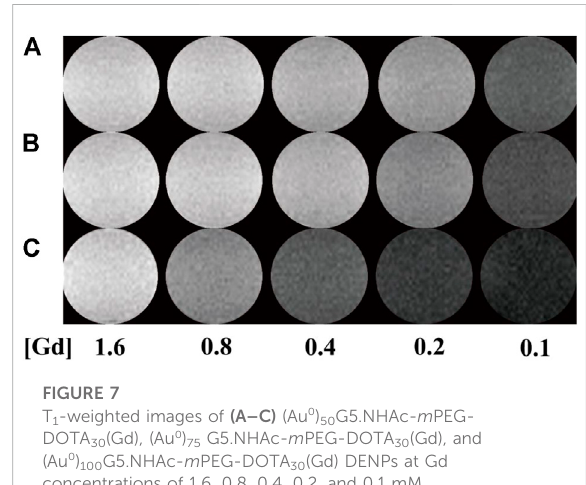
FIGURE 7 T 1 -weighted images of (A – C) (Au 0 ) 50 G5.NHAc- m PEG-